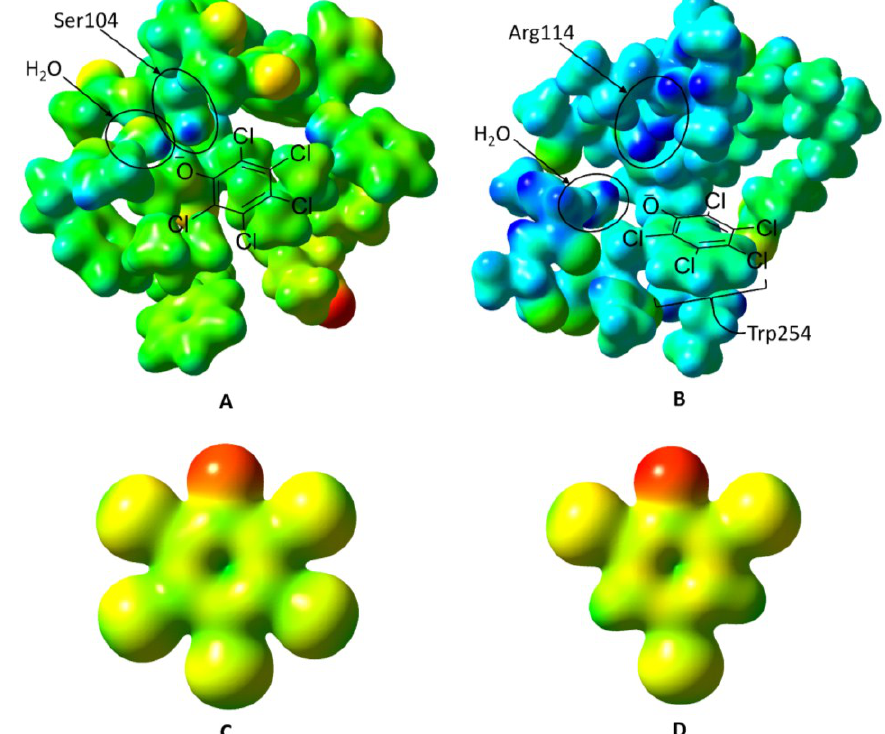
Figure 7. Electrostatic potential surfaces of PcpR’s two ligand-binding sites, pentachlorophenol, and 2,4,6-trichlorophenol. The electrostatic potential for Figures 7A through 7D were all mapped on a scale of −0.250 hartrees (red) to +0.300 hartrees (blue). ( A ) The inducer-binding site 1 (IBC1) of PcpR with His206 in the PCP-bound conformation. Ser104 and the water molecule that donates a hydrogen bond to PCP are indicated. The approximate PCP binding mode is shown as a ChemDraw (Version 14, CambridgeSoft, Cambridge, MA, USA) figure overlaid onto the electrostatic potential surface; ( B ) The inducer-binding site 2 (IBC2) of PcpR in the PCP-bound conformation. Arg114 and the water molecule that donates a hydrogen bond to PCP are indicated. The approximate PCP binding mode is shown as a ChemDraw figure overlaid onto the electrostatic potential surface; ( C ) The electrostatic potential surface of the pentachlorophenolate; and ( D ) The electrostatic potential surface of the 2,4,6-trichlorophenolate